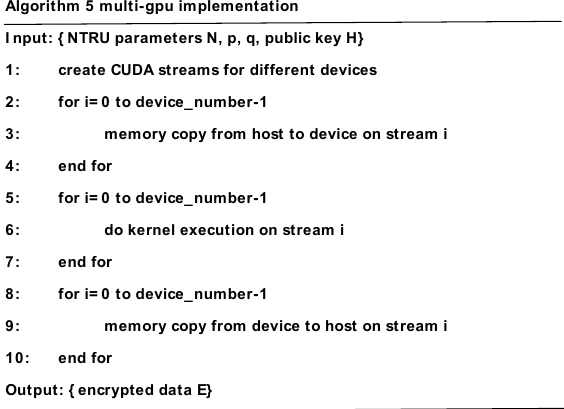
Algorithm 5 multi-gpu implementation